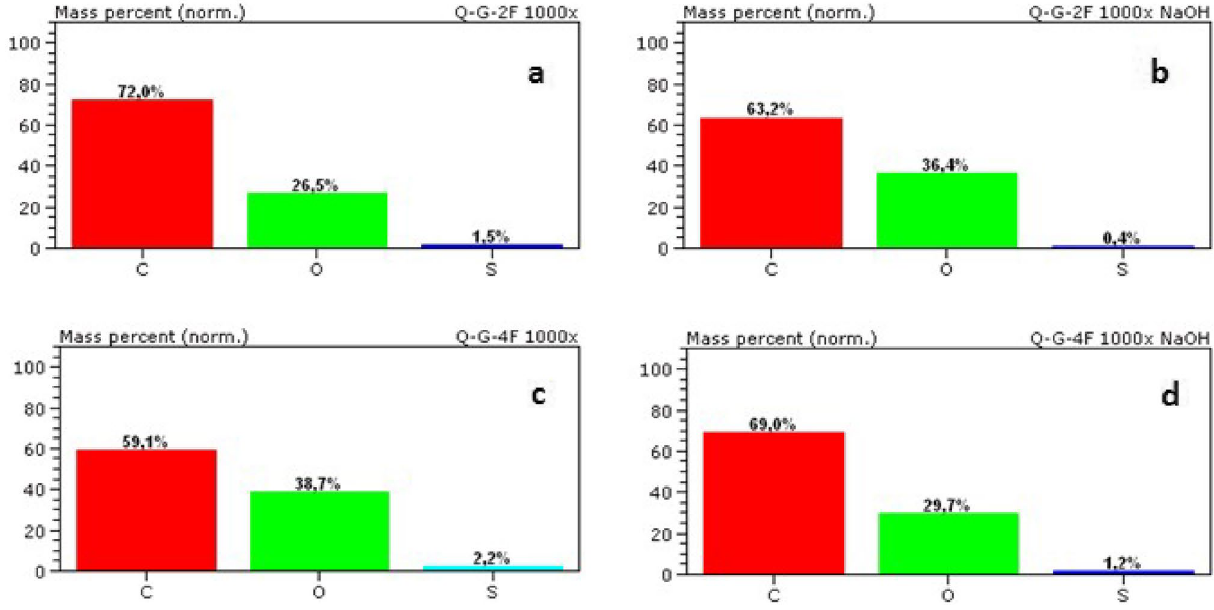
Fig. 4 Dispersive Energy Spectroscopy of chitosan membranes with gelatin and heparin: a chitosan with gelatin with 20 mg hepa- rin (Q/G/2H); b chitosan with gelatin with 20 mg heparin (Q/G/2H/